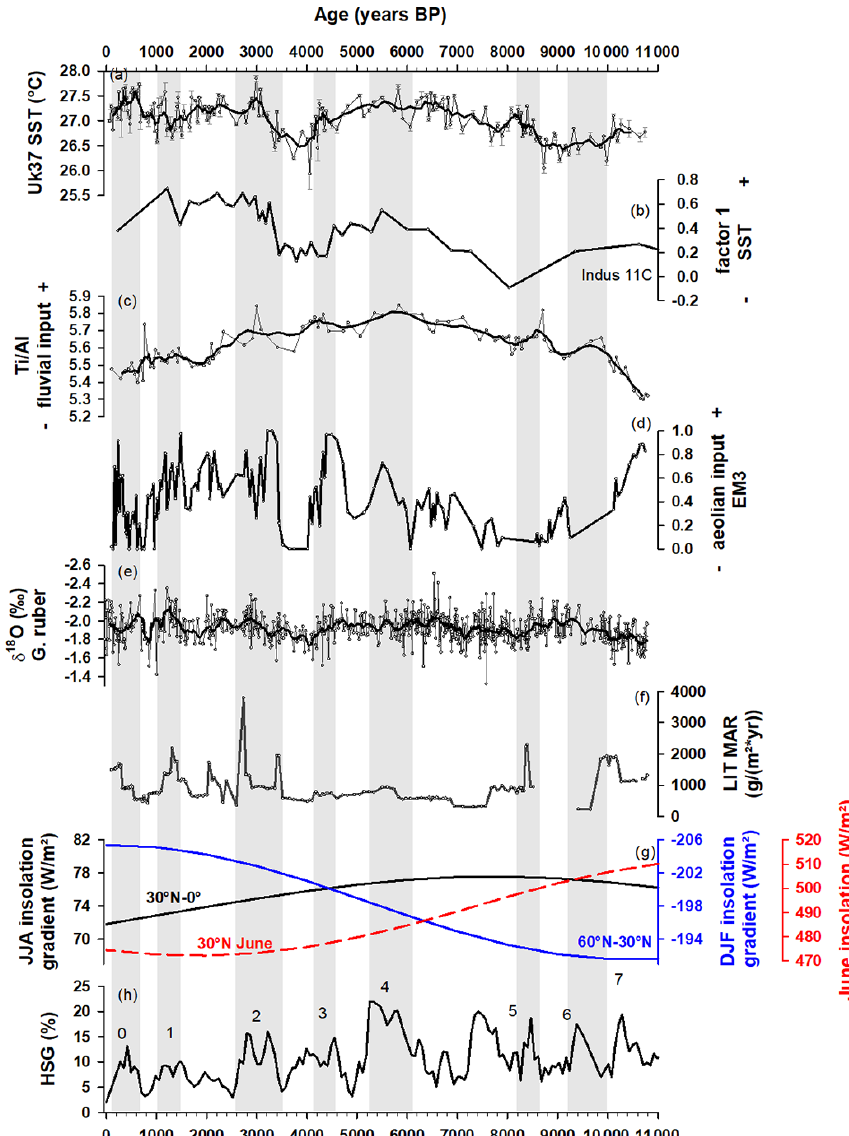
Figure 2. Environmental changes in the NE Arabian Sea. (a) Alkenone-based reconstructed SST of SO90-63KA. (b) Factor 1 based on DNA factor analyses of planktic foraminifera DNA interpreted as an SST and winter monsoon indicator in core Indus 11C (Giosan et al., 2018). (c) Ti / Al ratios indicating fluvial sediment input. (d) EM3 based on end-member modeling analyses of grain sizes as an indicator for eolian input (Burdanowitz et al., 2019a) and (f) lithogenic mass accumulation rates (LIT MAR) of SO90-63KA. (e) δ 18 O of Globigerinoides ruber of SO90-63KA (Staubwasser et al., 2003). (g) Latitudinal insolation gradients (LIGs) of summer (JJA: 30 ◦ N–0 ◦ ; black line) and winter (DJF: 60–30 ◦ N; blue line) and summer insolation at 30 ◦ N (dashed red line) (Laskar et al., 2004). (h) Stacked North Atlantic hematite stained grains (HSGs) representing drift ice in core MC52-V29191 with so-called Bond events (numbered gray bars) (Bond et al., 2001). Thick black lines in (a) and (c) indicate five-point running